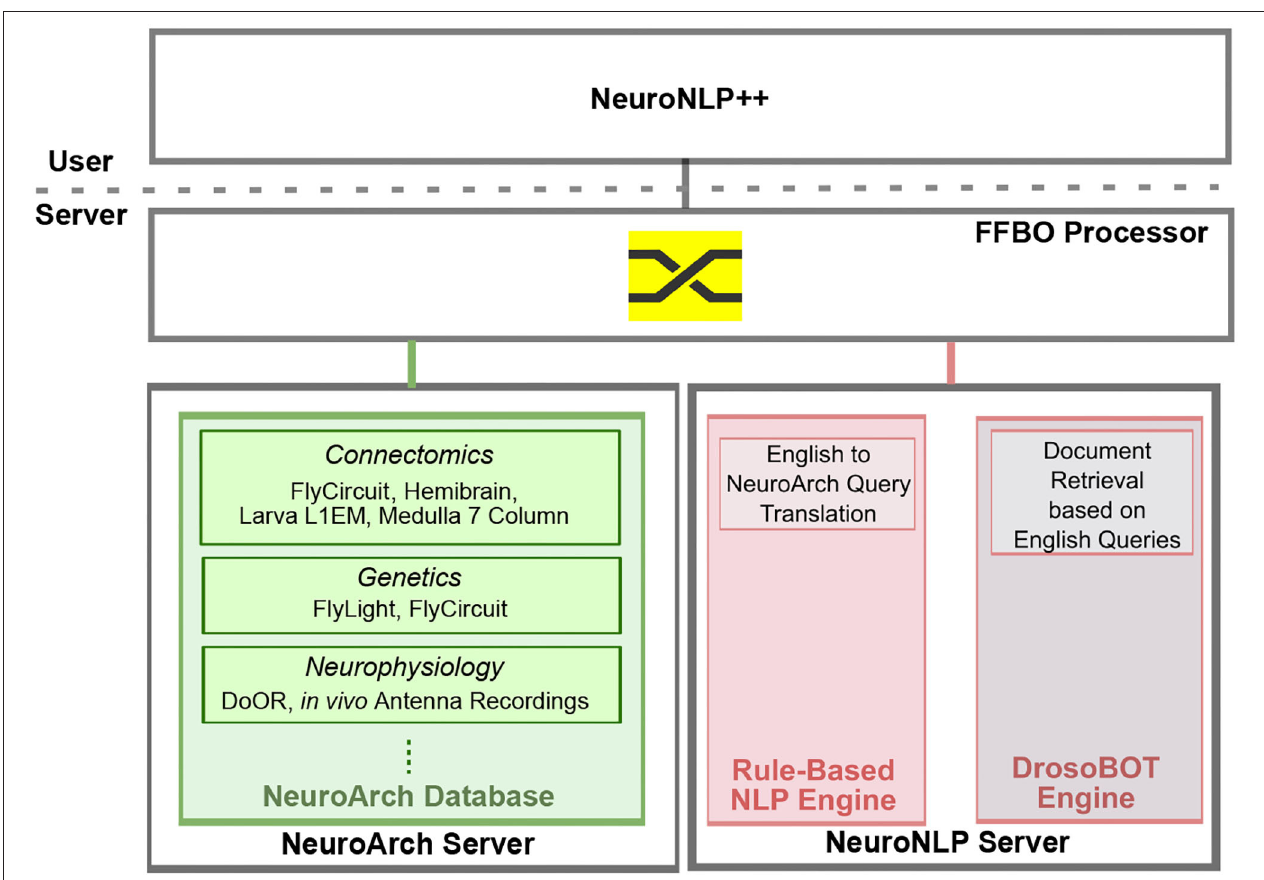
FIGURE 12 | Software architecture of the NeuroNLP ++ web application. The frontend application communicates with three backend servers: a NeuroArch Server that hosts a NeuroArch Database of fruit fly brain datasets, a NeuroNLP Server that runs the rule-based NLP Engine, and, an additional NeuroNLP Server that runs the DrosoBOT